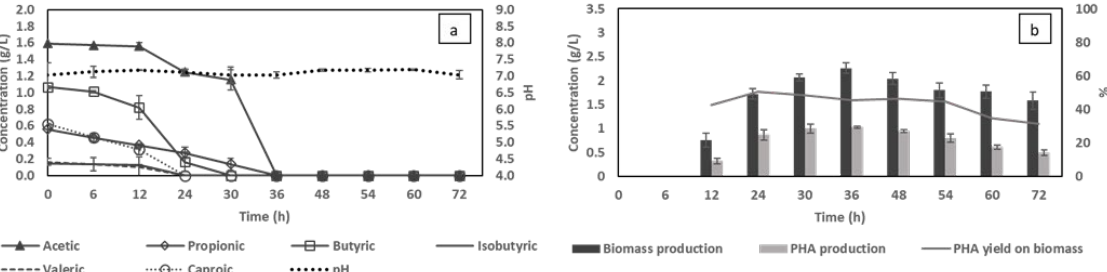
Figure 6. Changes in volatile fatty acid (VFA) consumption ( a ), and biomass and PHA production ( b ) using food waste-derived VFA effluent in a bioreactor using optimal cultivation conditions.